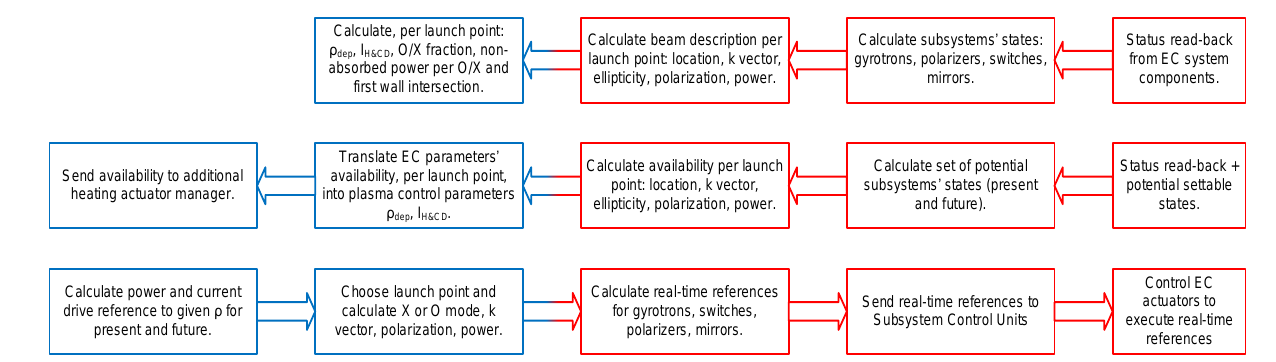
Fig. 6. Information flow for Plasma Control Functions between ECPC and